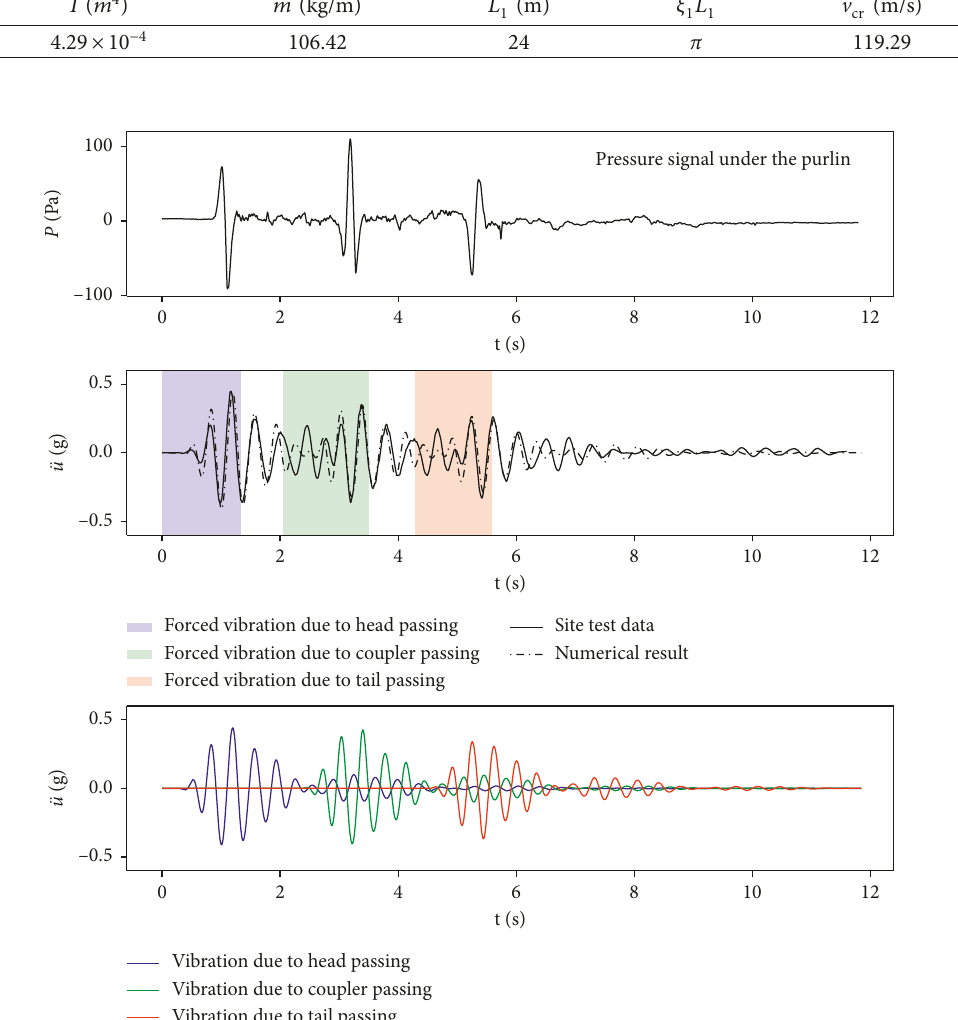
Figure 11: Pressure signal and comparison of accelerations of the purlin between site test data and numerical result for the high-speed train with speed